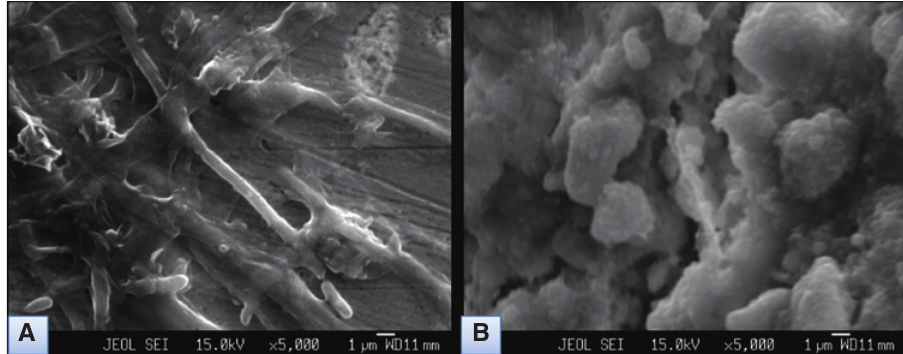
Figure 7: Scanning electron micrograph of: (A) normal, (B) lysed mycelium of Trichophyton rubrum.